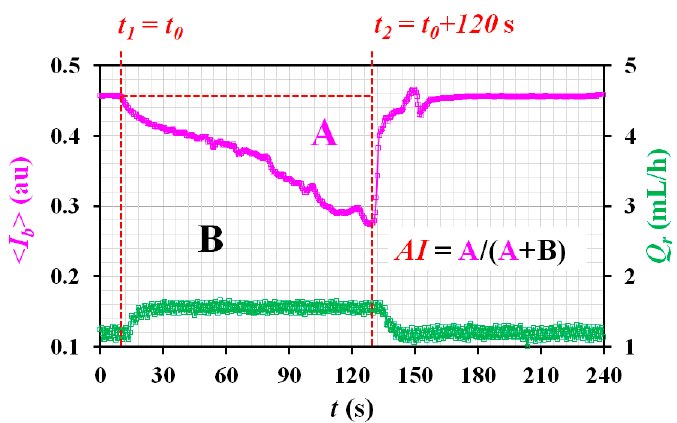
19 of 21 Figure A3. Quantification of three blood biophysical properties obtained by analyzing blood flows controlled with a syringe pump. ( A ) Quantification of junction pressure ( P j ) and pressure-induced